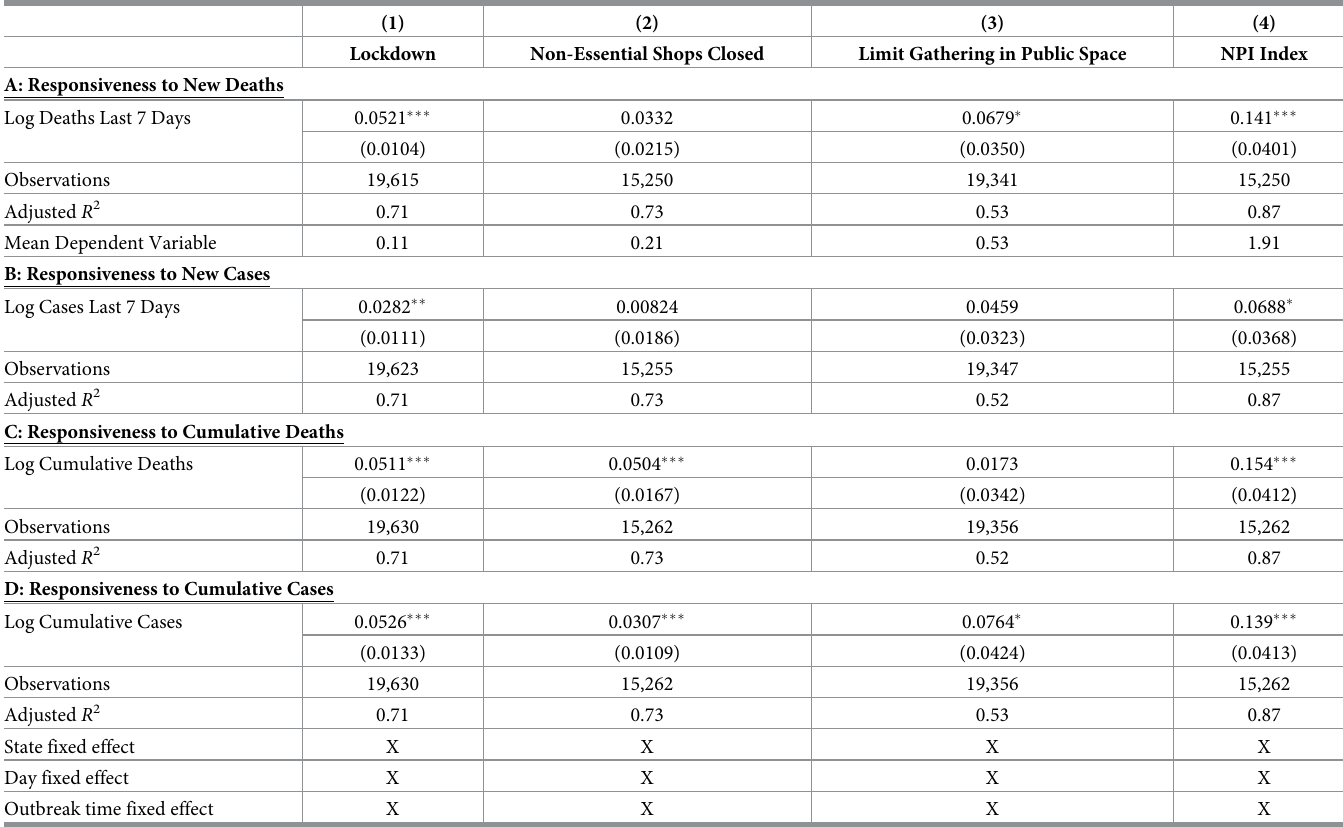
Table 4. State government responsiveness to